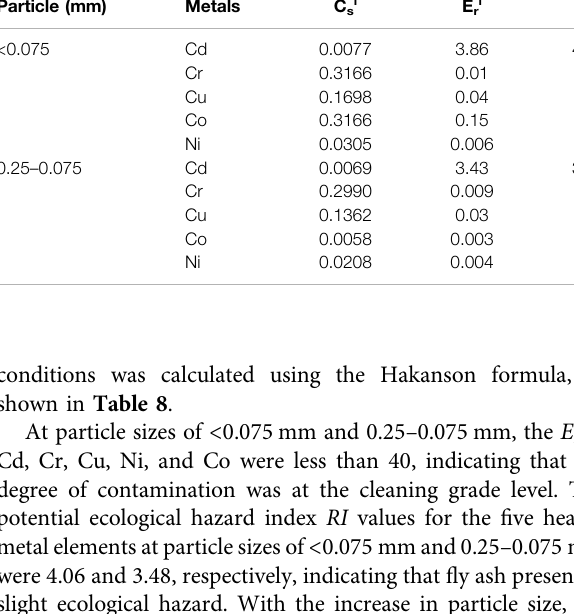
TABLE 7 | Hakanso potential ecological risk index under different temperature conditions. Temperature ( ° C) Metals